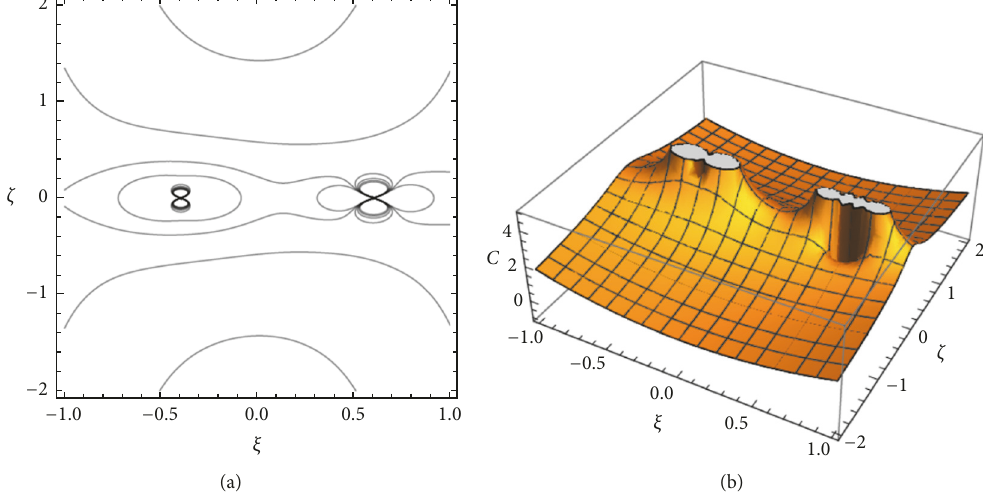
Figure 1: Zero-velocity curves in the ( 𝜉 − 𝜁 ) plane of PSR 1903+0327 for 𝐴 = 0.01,𝑎 = 0.95, 𝜎 1 = 0.03 and 𝜎 2 = 0.015 .